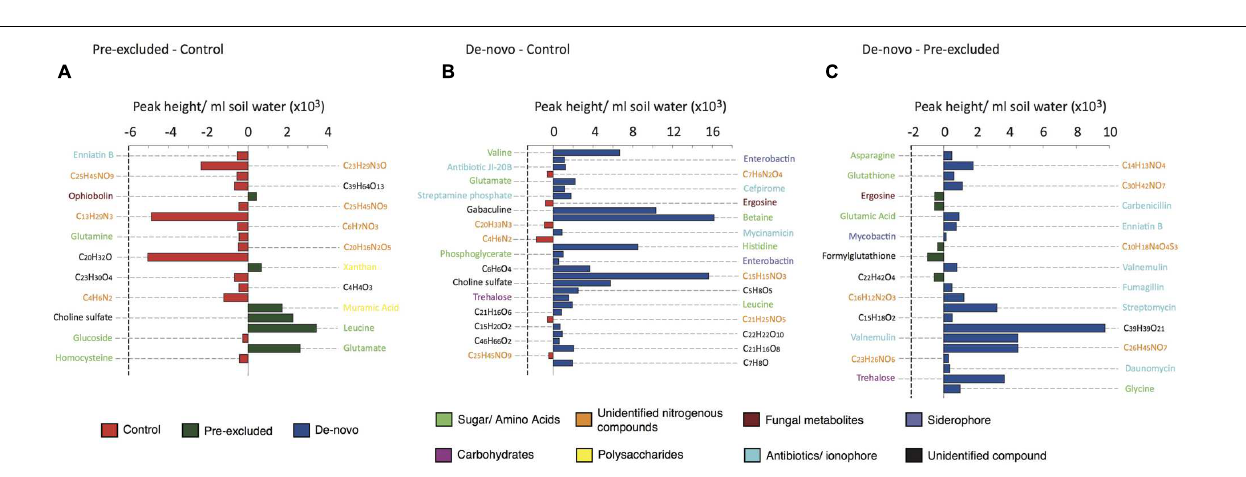
FIGURE 2 | Comparative abundance and putative identification of the top 20 key metabolites statistically differentiating the control and drought sites. Individual panels show the pairwise analysis between (A) control plots and pre-excluded plots, (B) control plots and de-novo plots, and (C) pre-excluded plots and de-novo plots. The bars are coded by site (control, re-excluded, and de novo ), and the broad classes of the different compounds are